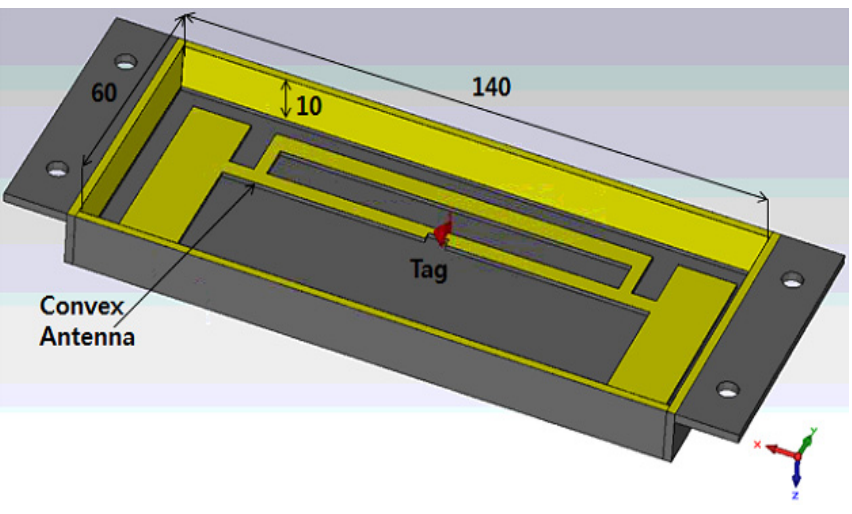
Figure 3. 3D shape of the convex cavity structure tag antenna .